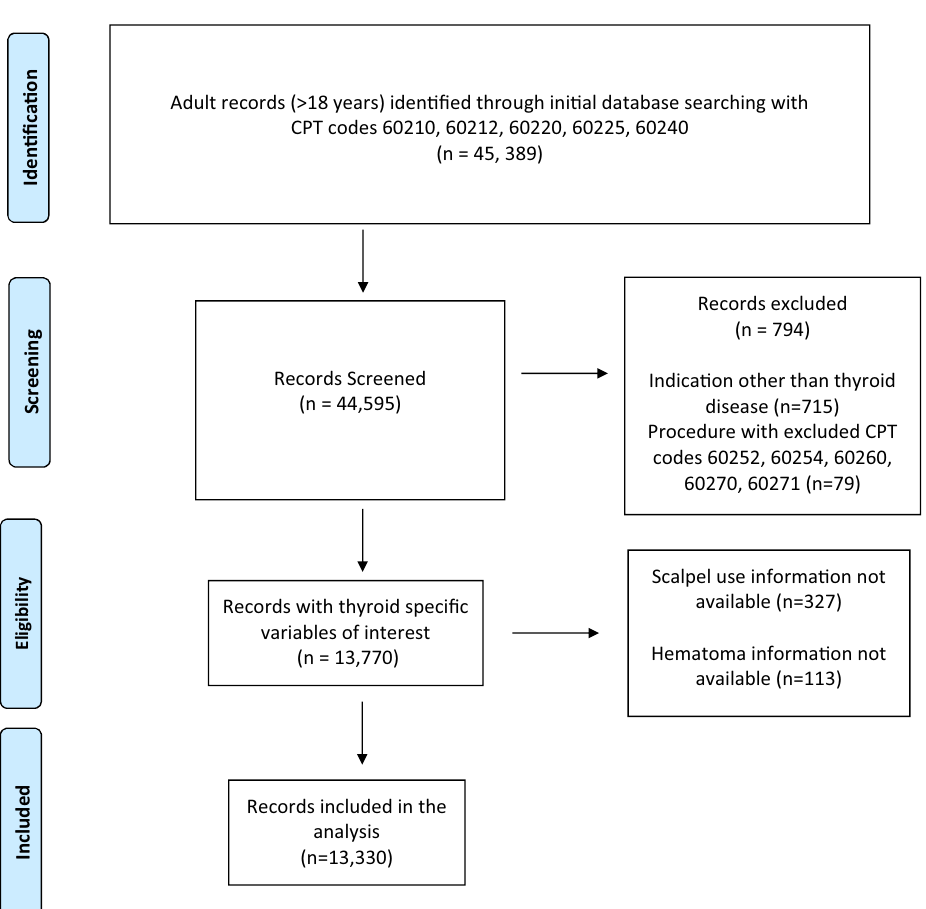
Figure 1. Record inclusion diagram. n number of patient records, CPT current procedural technology